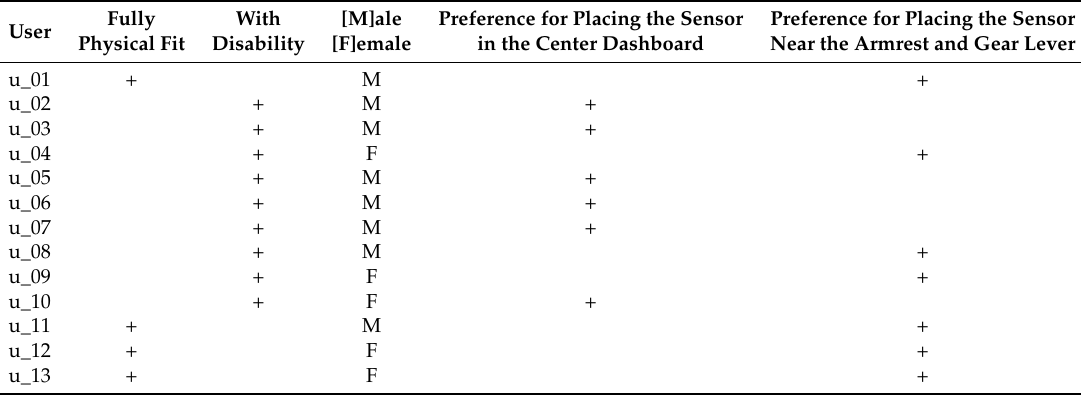
Table 2. Characteristics of research